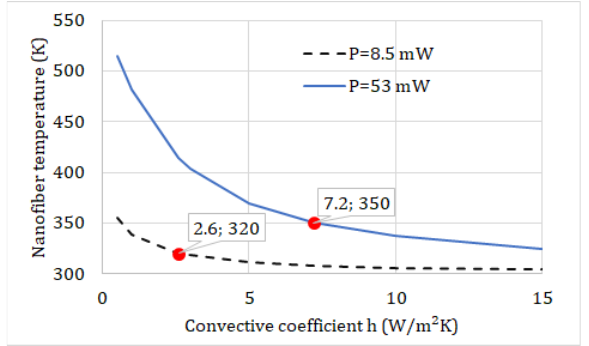
Fig. 3. Simulated nanofiber temperature versus the convective coefficient h for two different pump powers. Red points are experimental data.